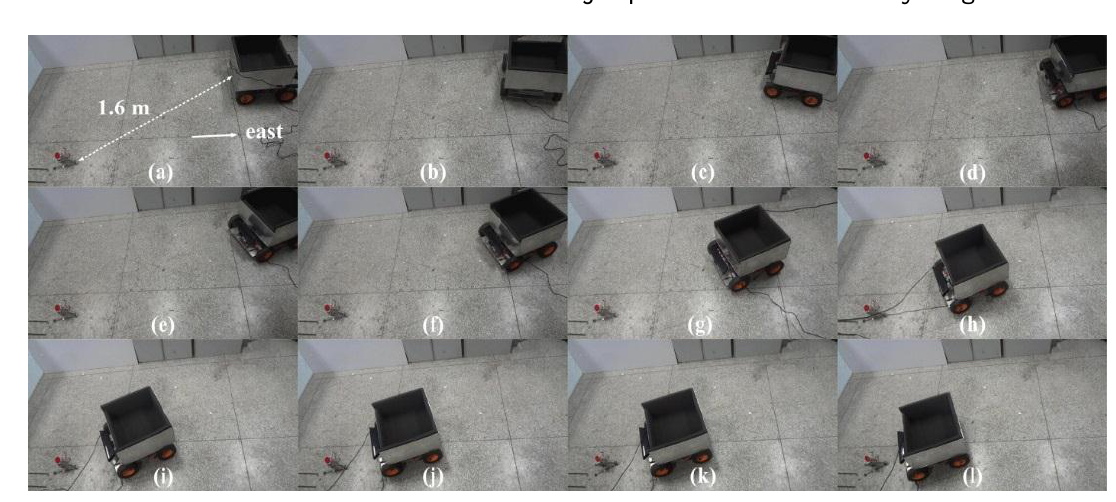
Figure 20. Video sequences of the orientations and position automatic detection process: ( a ) initial condition; ( b ) carrier steers anticlockwise about 80°; ( c ) carrier steers continuously; ( d ) carrier finds the JSN is in the video images; ( e ) carrier steers and calculates ζ and O cj step by step until they are close to zero; ( f ) carrier moves to the JSN; ( g ) carrier moves to the JSN continuously; ( h ) carrier moves to the JSN continuously; ( i ) carrier stops in front of the JSN; ( j ) carrier detects orientation O jc ; ( k ) JSN steers angle O jc ; ( l ) carrier moves to the JSN